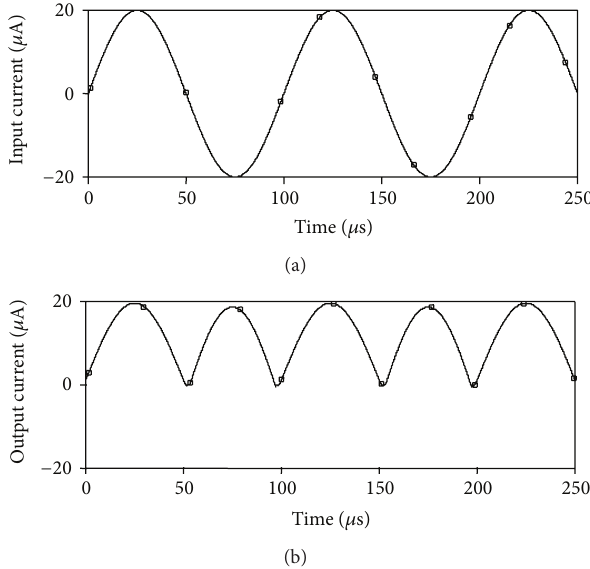
Figure 5: Input and output waveforms for sinusoidal